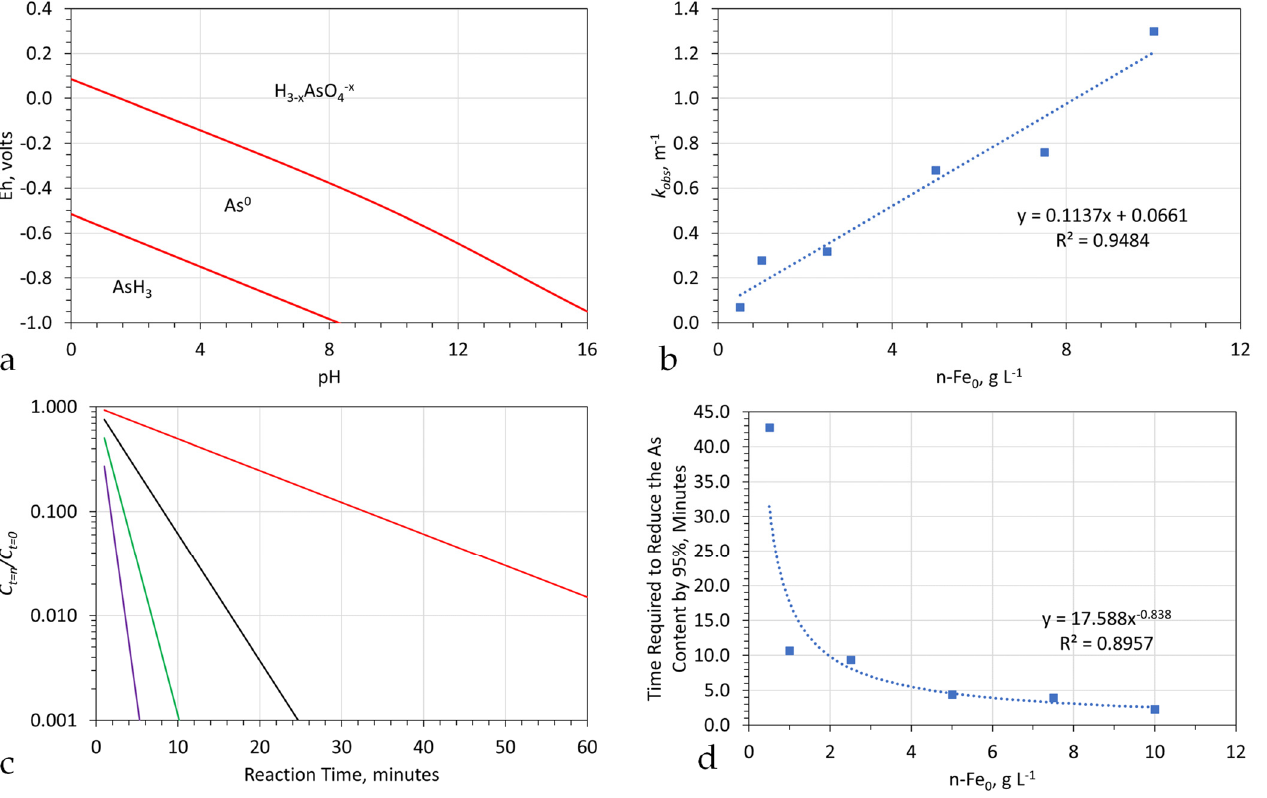
Figure A27. Arsenic—Uncoated n-ZVI, 10–100 nm, a s = 37.2 m 2 g − 1 . ( a ), Redox stability fields. ( b ), relationship between the observed rate constant and Fe 0 concentration, g L − 1 ( P w ) 10–100 nm, a s = 37.2 m 2 g − 1 ; As ion concentration = 100 mg L − 1 . If the intercept is set at 0, then k obs = 0.123 P w , R 2 = 0.9793, and k obs = 0.0033 P w a s ; ( c ), As concentrations as a function of reaction time and n-Fe 0 concentration. Red = 0.5 g L − 1 ; black = 1 g L − 1 ; green = 5 g L − 1 ; purple = 10 g L − 1 ; ( d ), time required to remove 95% of the As, versus P w